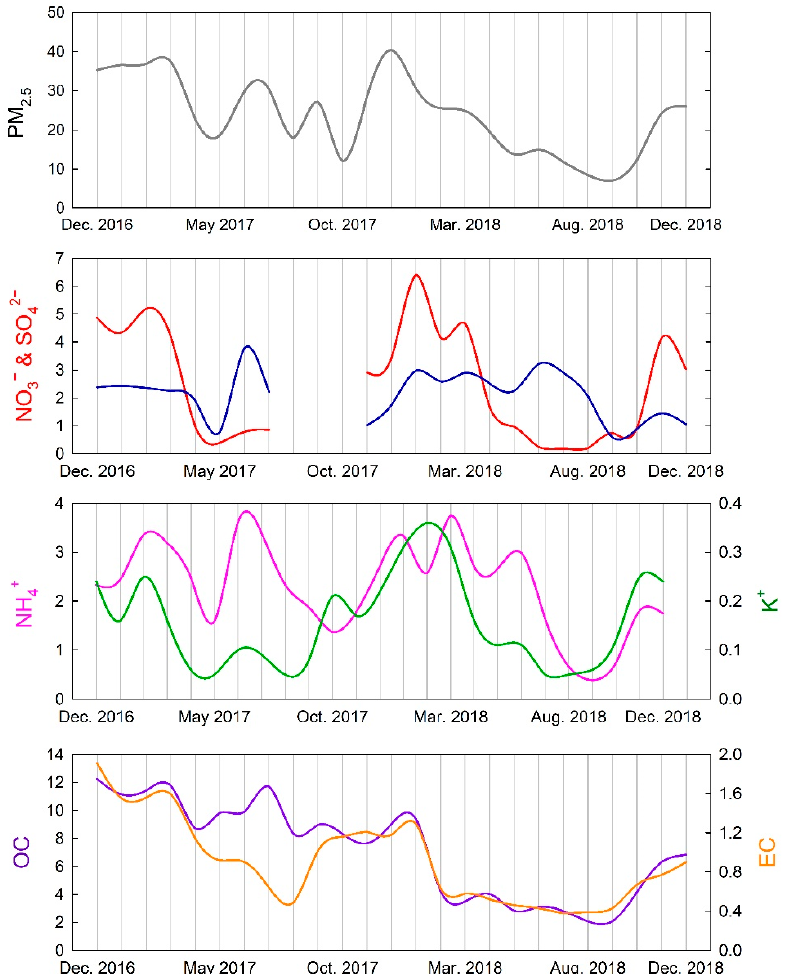
Figure 2. Monthly concentrations of PM 2.5 and its major components expressed as arithmetic means. Units are μ g m − 3 for PM 2.5 and its species. Table 2. Seasonally averaged PM 2.5 constituent concentrations ( μ g m − 3 ).